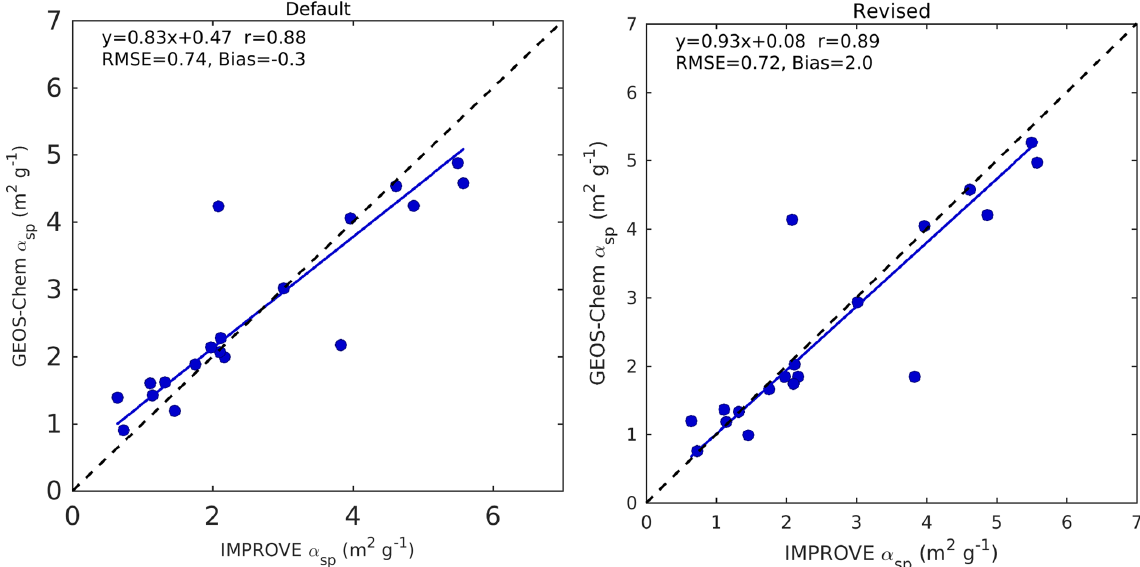
Figure 12. Coincident simulated vs. measured average mass scattering efficiency at 550nm for the year 2006, using default and revised optical tables. Slope, offset, and correlation coefficient are